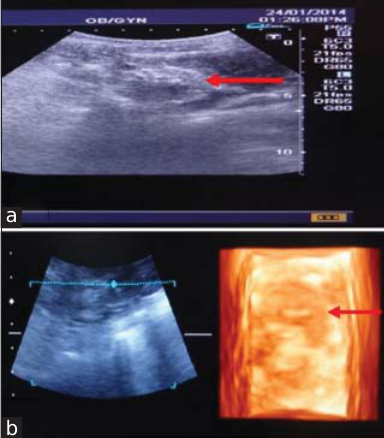
Figure-3: End-stage kidney (Case 1): (a) In two- dimensional ultrasonogram of kidney, small sized kidney appears without distinct margins (red arrow) and differentiation of cortex and medulla, (b) in three- dimensional ultrasonogram of kidney, small sized kidney appears without distinct margins (red arrow).